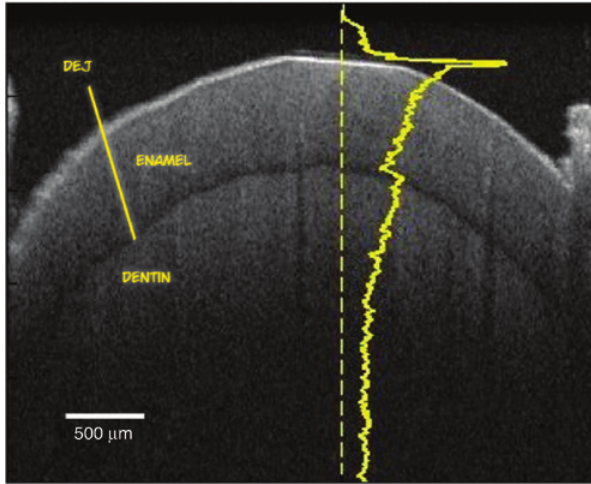
Figure 5: OCT image showing the enamel and dentin layers and also the DEJ. These anatomical structures are confirmed by the A-scan of a selected point, presented in the form of yellow lines, showing the peaks of various tissue layers due to the differences in their refractive